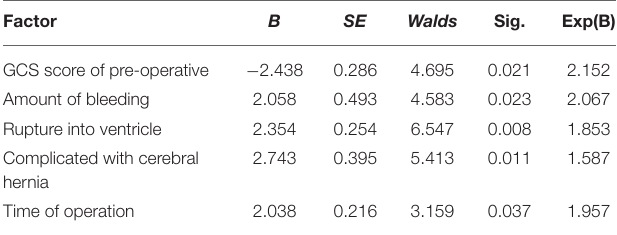
TABLE 6 | Multivariate analysis of prognosis of patients. Factor B SE Walds Sig.